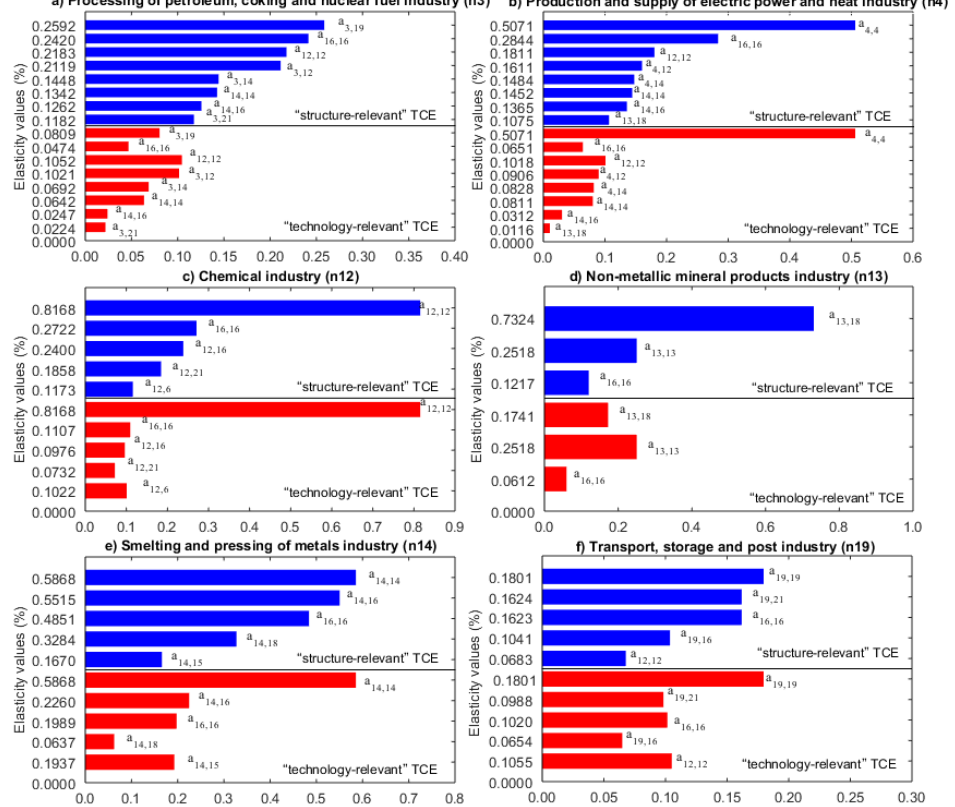
Figure 4. Elasticity values for technology coe ffi cient ( B ) based on sensitivity analysis. The top 6 emission-intensive sectors are considered in sensitivity analysis: a Processing of petroleum, coking, and nuclear fuel (n3), b Production and supply of electric power and heat (n4), c Chemical (n12), d Non-metallic mineral products (n13), e Smelting and pressing of metals (n14) and f Transport,